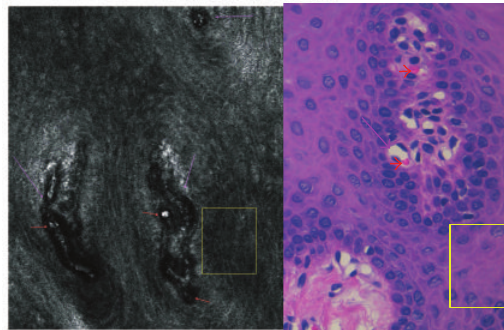
Figure 9: Reflectance confocal microscopy findings at the basal cell layer and epithelial junction with histologic correlation. Purple arrows: blood vessels, Red arrows: erythrocytes and blood vessel traffic, Yellow square: loss of honeycomb pattern.